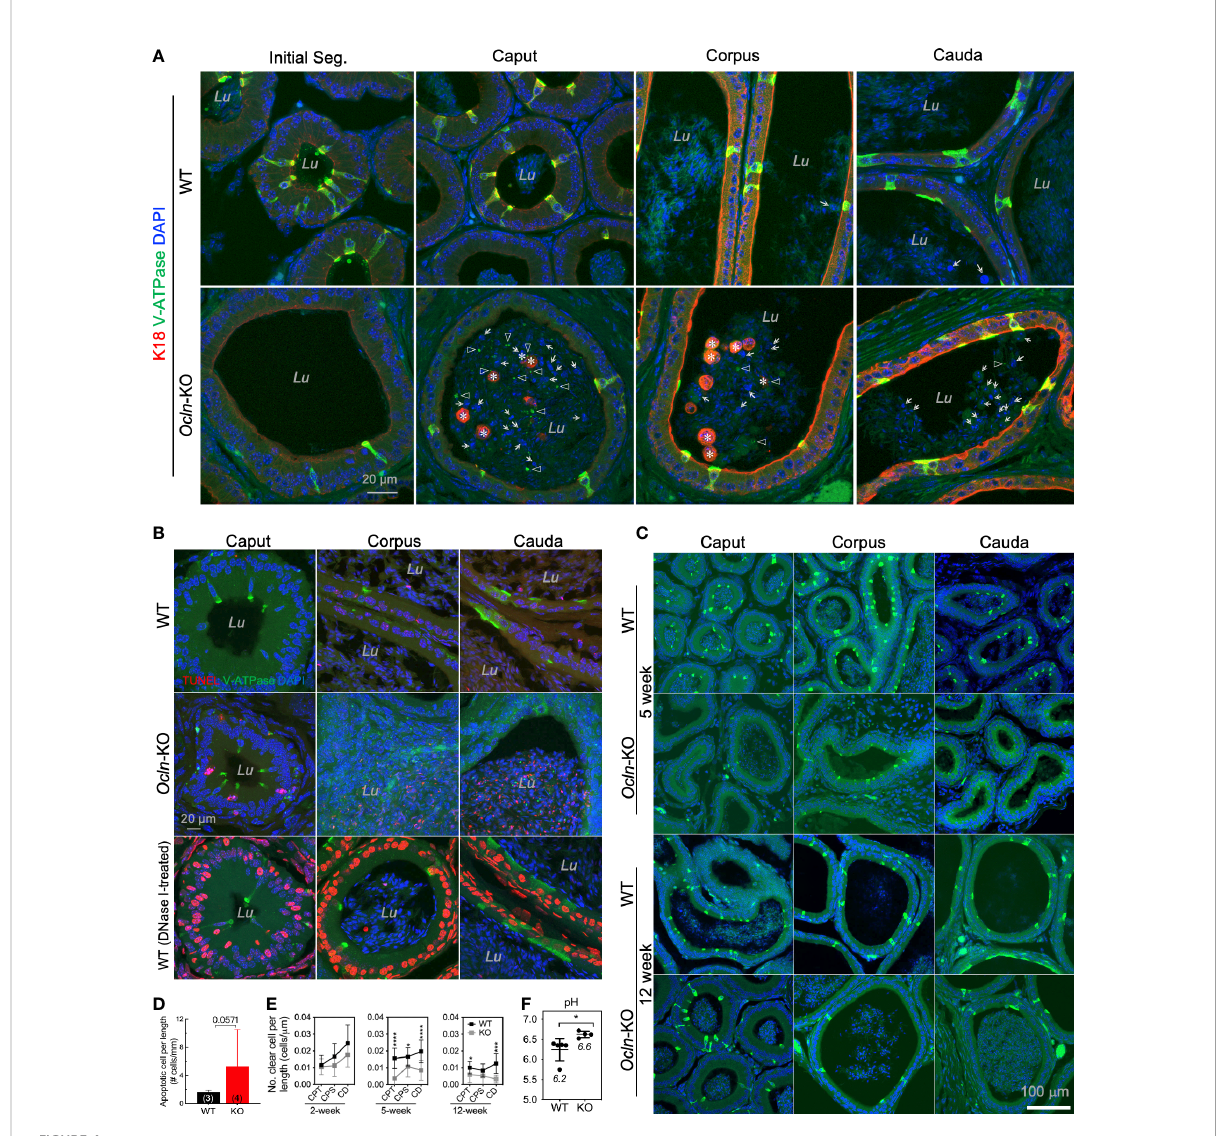
FIGURE 4 Increased luminal pH in distal epididymis and the loss of proton-pump expressing clear cells in the OCLN-de fi cient mice. (A) Immuno fl uorescent staining of epididymal cryosections for clear cell marker B1-V-ATPase and epithelial marker intermediate fi lament keratin-18 (K18) showing increased shed epithelial cells in the epididymal lumen of Ocln- KO ( Ocln -/- ) compared to WT ( Ocln +/+ ) mice. Lu: lumen. Triangles: B1-V-ATPase-positive cell debris in the lumen. Asterisks: keratin-18-positive epithelial cells (both principal cells and clear cells) shed into the lumen. Arrows: keratin-18-negative cells in the lumen. (B) TUNEL staining for the different regions of epididymis from WT and Ocln- KO mice showing increased apoptotic index in the distal epididymal lumen ( Lu ). (C) Representative immuno fl uorescent staining images of epididymal cryosections for clear cell marker B1-V-ATPase (green) con fi rmed the decreased numbers of clears in all the regions of epididymis from Ocln- KO mice, compared to WT mice. (D) Quantitative TUNEL-positive epithelial cells in the epithelium and in the lumen of epididymis of WT (n = 3) and Ocln- KO (n = 4) mice. (E) Quanti fi cation of the numbers of clear cells per epithelial length statistic in WT and Ocln- KO mouse epididymis during development. Data represent means ± SD (n ≥ 3 animals per group, two-way ANOVA * P <0.05, *** P< 0.001, **** P <0.0001). CPT, caput; CPS, corpus; CD, cauda epididymidis. (F) Increased pH detection in the luminal fl uid of vas deferens in Ocln- KO mice compared with WT mice. Two-tailed unpaired t-test, * P <0.05 (n>4 animals per